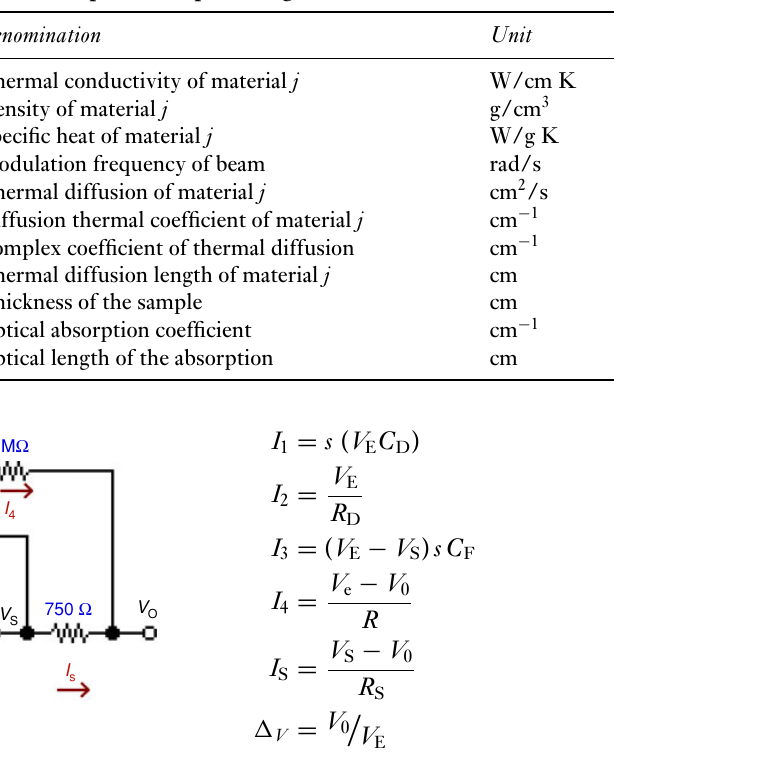
Table 1 Notation for the description of optical signals